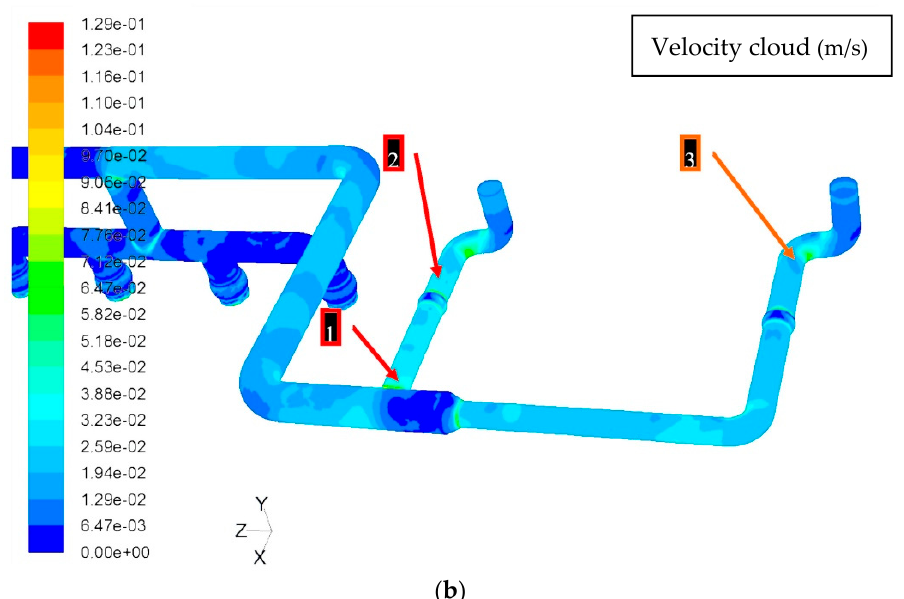
Figure 27. The erosion distribution map of pipeline 01-EA002/1, ( a ) General view of erosion division; ( b ) Partial view of erosion division.